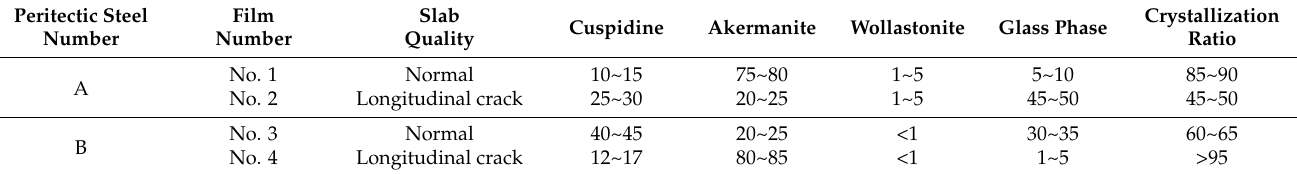
Table 4. Mineralogical compositions, proportions, and crystallization ratio of flux films